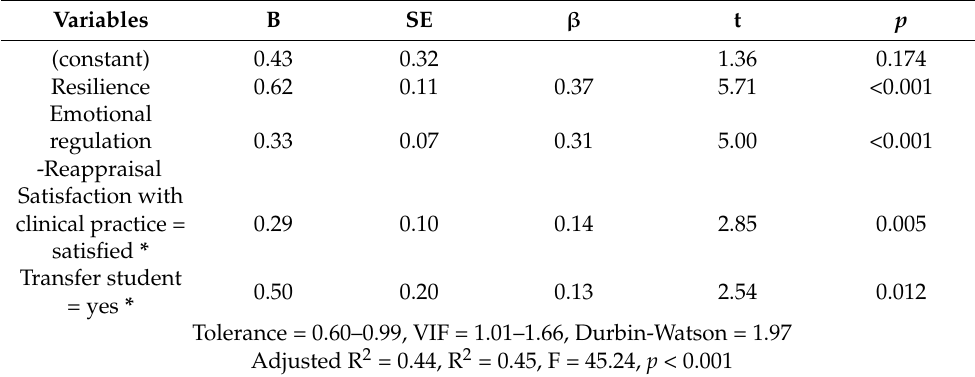
Table 4. Influencing Factors on Post-Traumatic Growth (N =